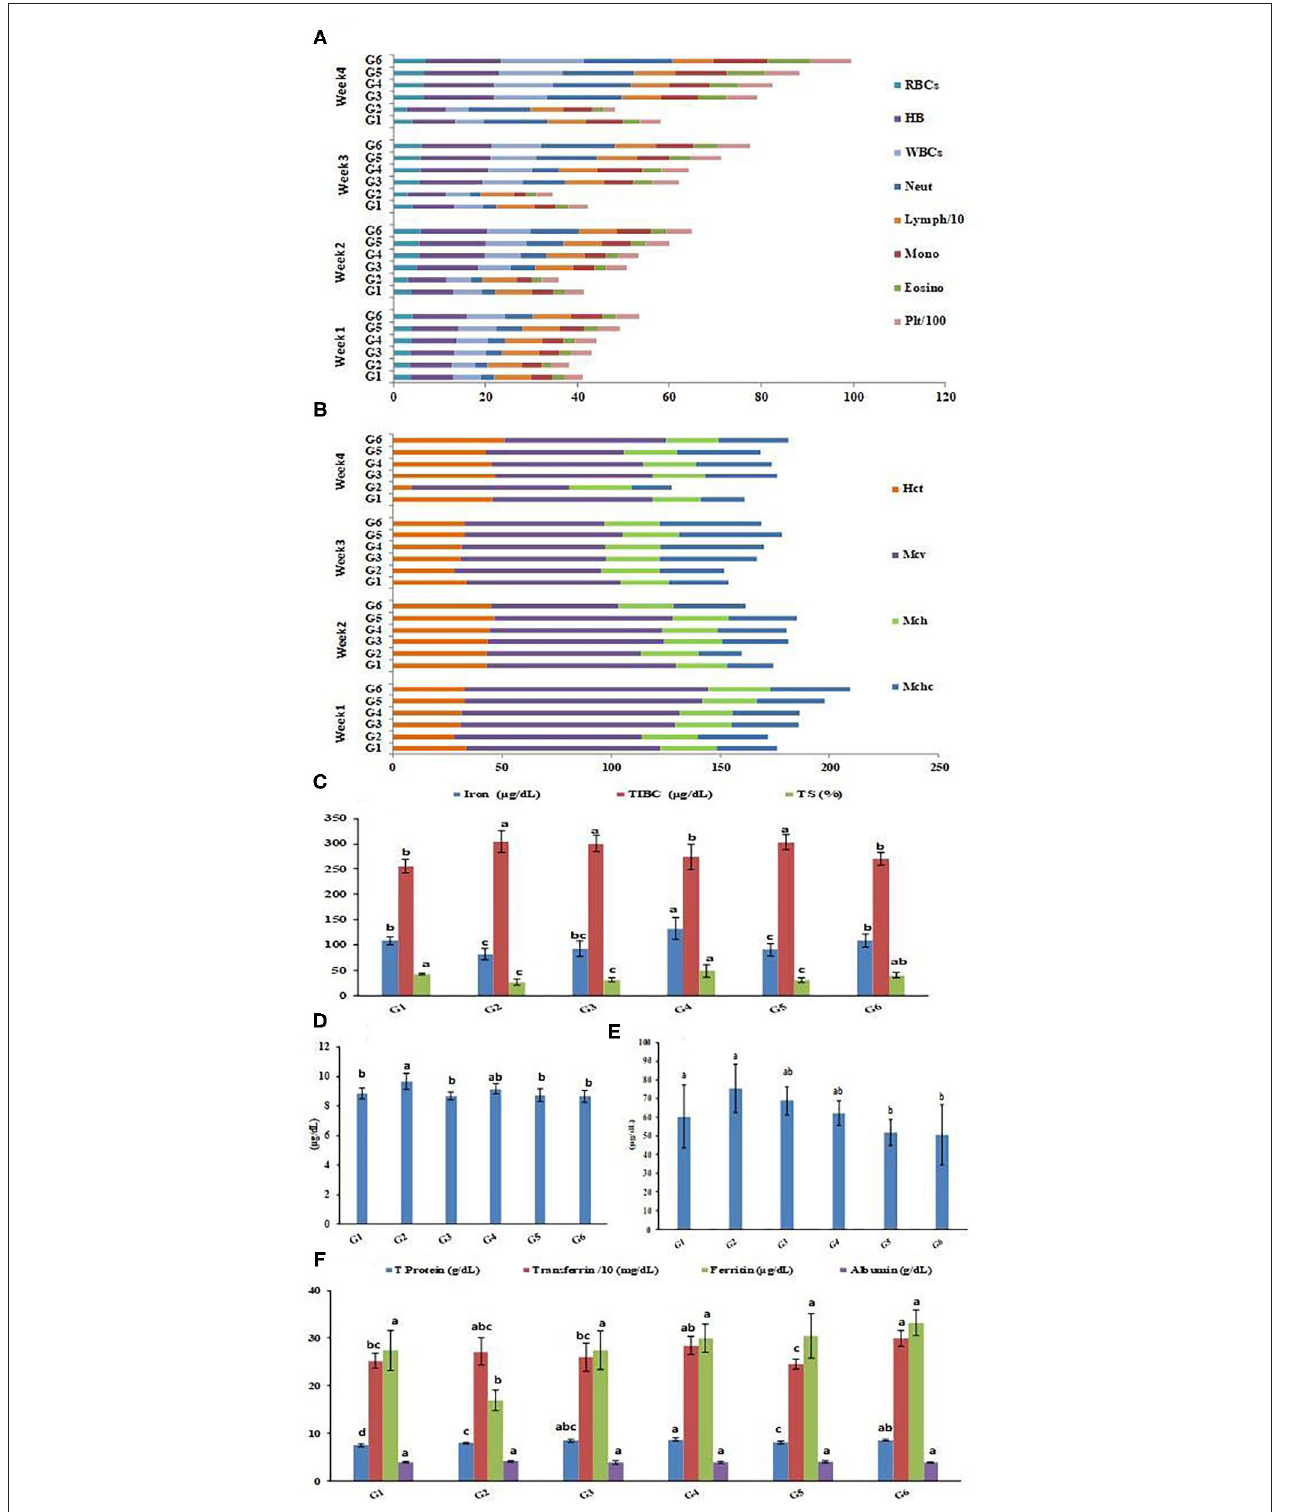
FIGURE 7 | CBC (4 weeks of treatment) and serum profile of rats groups. (A) Complete blood cell count (CBC). (B) Red cell indices. (C) Iron parameters in rats groups. (D) Calcium concentrations in rats groups. (E) Zinc concentrations in rats groups. (F) protein parameters in rats groups. Serum profile data represented